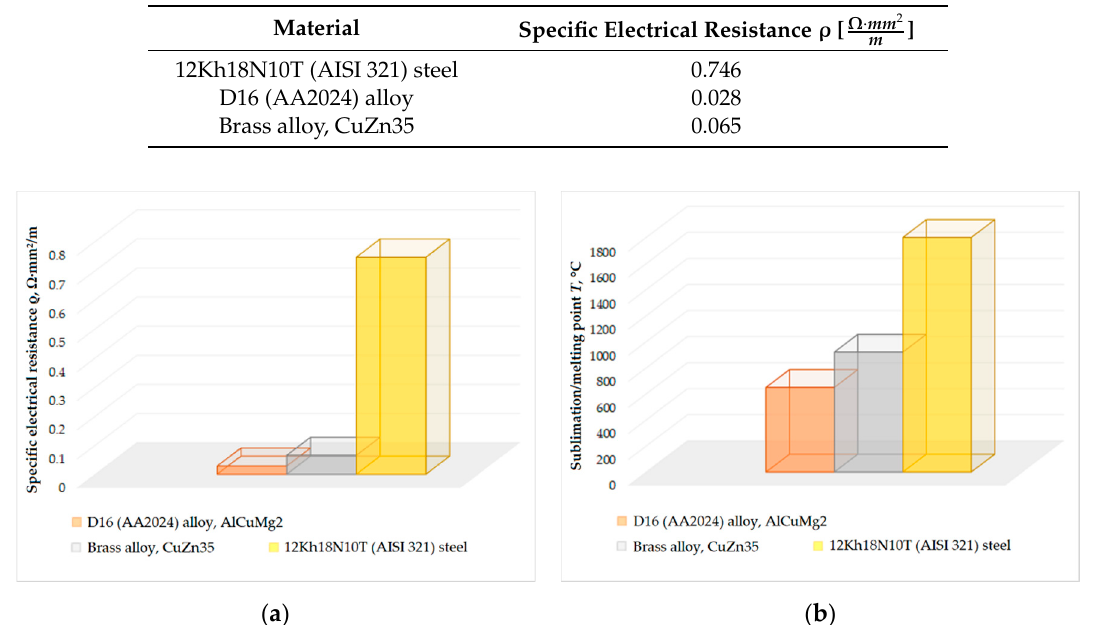
Table 5. Specific electrical resistance ρ of some materials at +20 °C.